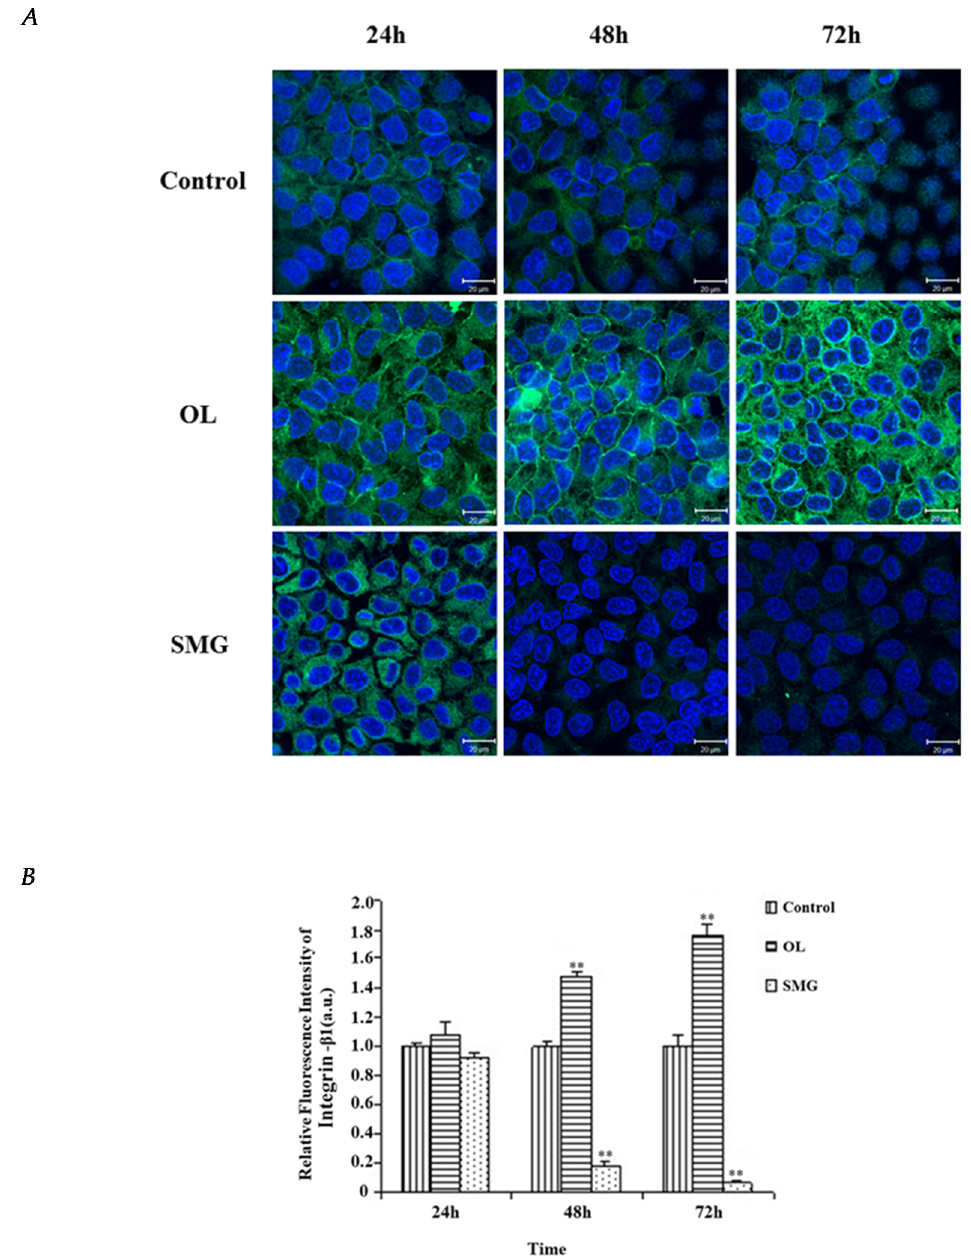
Figure 3. The expression of integrin β 1 in HUVEC cells after mechanical treatment. ( A ) The results of immunofluorescence experiments. The blue color indicates the nucleus, and the green color represents the integrin β 1 protein. a. 24 h Control; b. 48 h Control; c. 72 h Control; d. 24 h Overload; e. 48 h Overload; f. 72 h Overload; g. 24 h SMG; h. 48 h SMG; i. 72 h SMG. ( B ) Relative fluorescence intensity of integrin β 1 in HUVEC cells. significant di ff erence; ** p < 0.01, extremely significant.